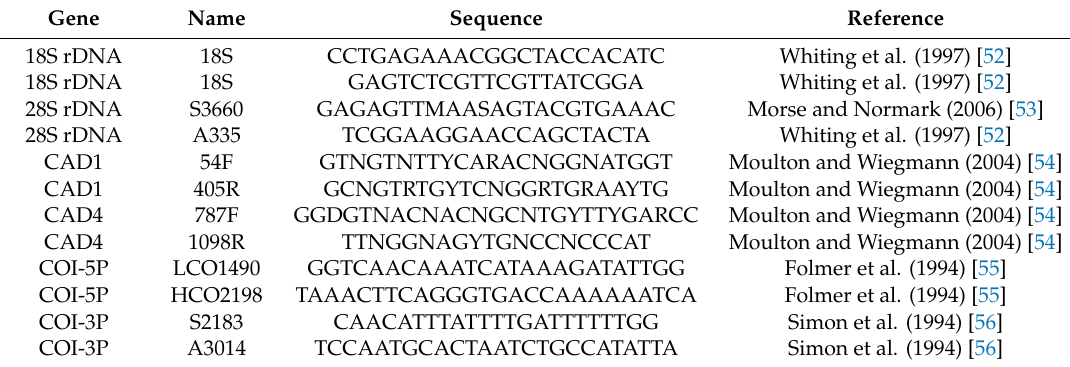
Table A1. Primers used for polymerase chain reaction amplification and